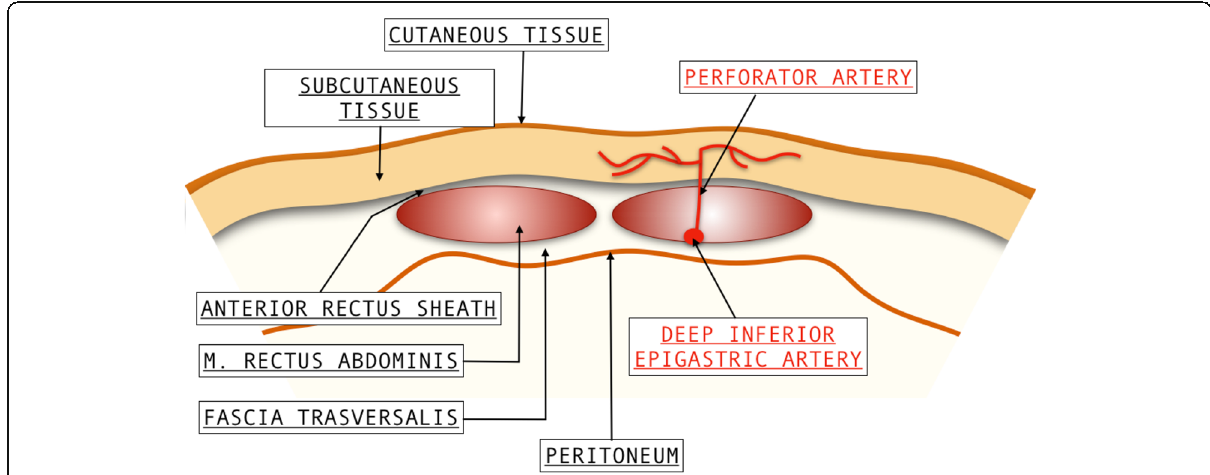
Fig. 2 Extra-abdominals arteries or vein: inferior epigastric vessels lacerations can lead to rectus abdominis sheath hematoma or to subfascial